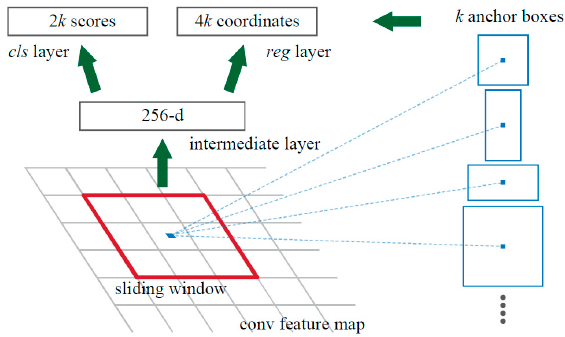
Figure 9. Region proposal network [36].